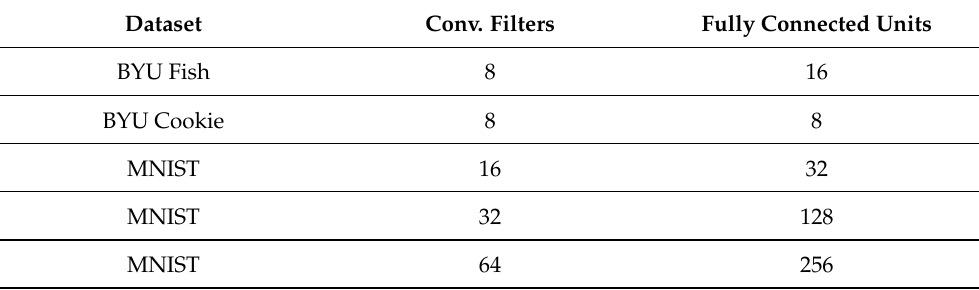
Table 1. The layer sizes used for each